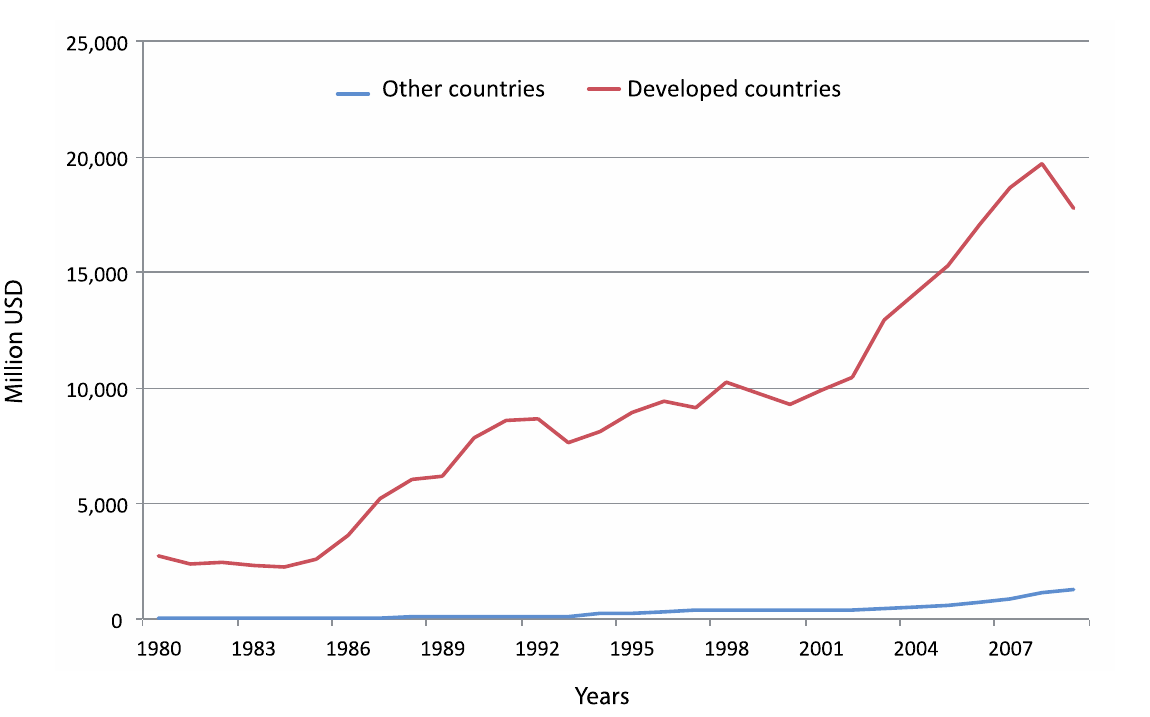
Figure 6. Imports (in million USD). (source: